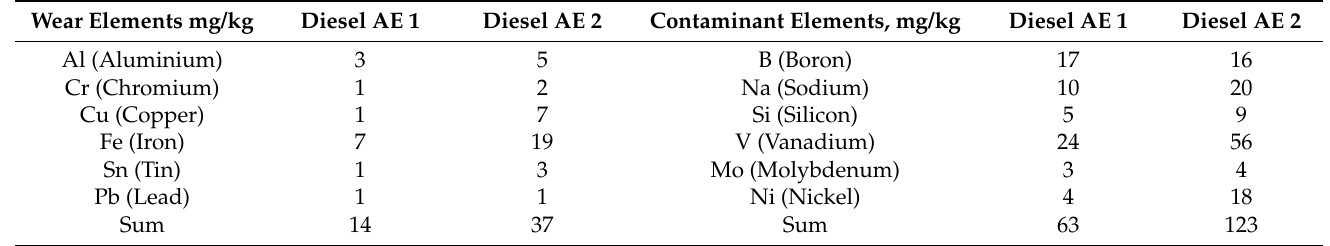
Table 3. Results of spectrographic oil analysis Shell Gadinia AL 40 after 1000 h of operation in a diesel circulation system 5L23/30 MAN-B&W Diesel Group.